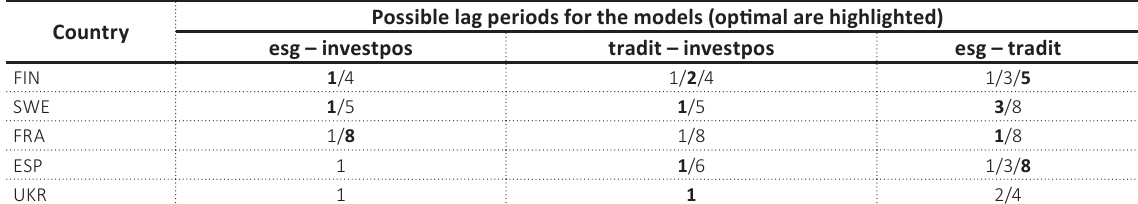
Table 11. Determining the optimal number of